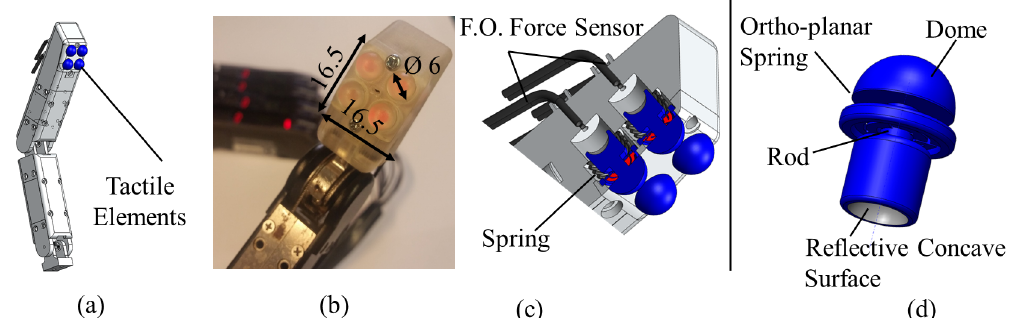
Figure 1. Fibre optical fingertip tactile sensor: ( a ) design of the fingertip fiber optical sensor; ( b ) photo of sensor integrated with prototype fingertip, dimensions are shown in mm; ( c ) section view of the fingertip sensor: fingertip tactile array; ( d ) hemispherical dome-shaped element.